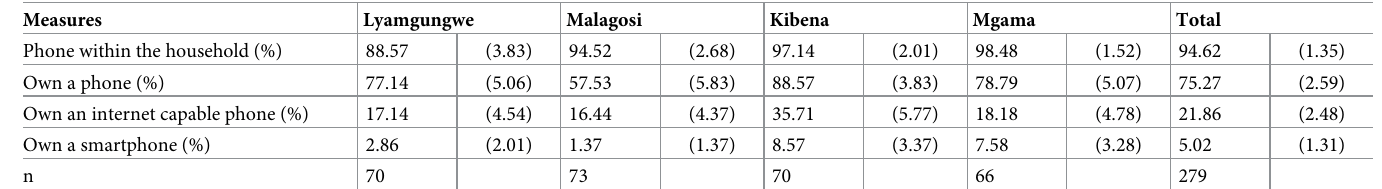
Table 2. Phone ownership means (and standard errors) stratified by study village. Binary variables are reported as proportions.